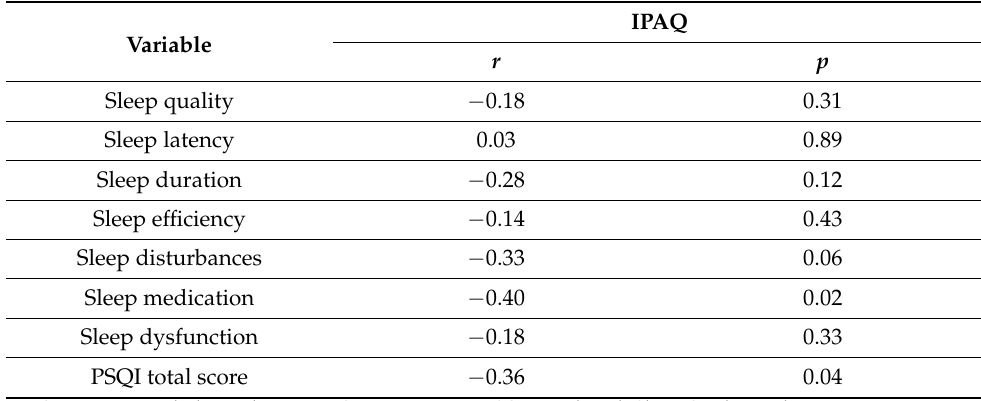
Table 4. Correlation analysis between IPAQ and sleep quality